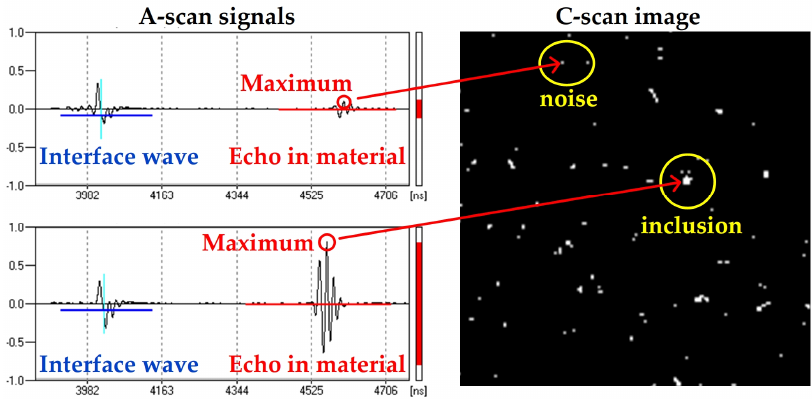
Figure 4. Schematic diagram of imaging.